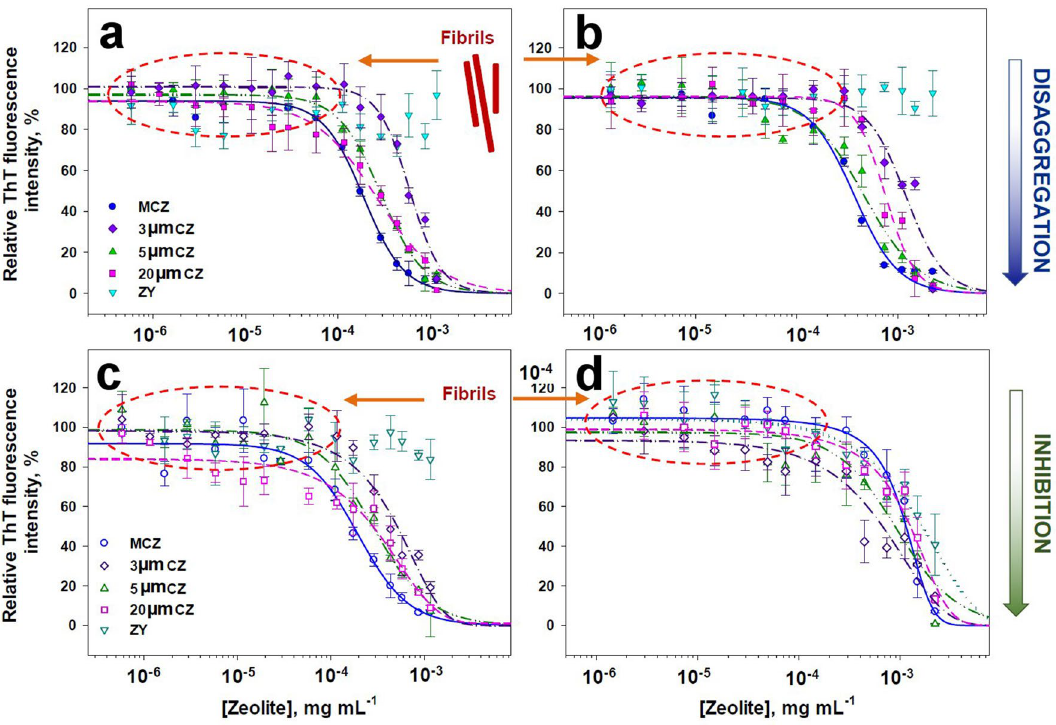
Figure 5. Quantification of CZ’s anti-amyloidogenic activity. Determination of the half-maximal disassembling concentrations of CZ particles for insulin ( a ) and lysozyme ( b ) and half-maximal inhibiting concentration for insulin ( c ) and lysozyme ( d ) quantified using ThT fluorescence assay. ThT fluorescence intensities of amyloid fibrils incubated in the presence of CZ particles ( a , b ) and amyloid fibrils formed in presence of CZ particles ( c , d ) were normalized to fluorescence measured after incubation of studied protein amyloid fibrils in the absence of CZs (taken as 100%). Each experiment was performed in triplicates; error bars represent the average deviation for repeated measurements of three separate samples.